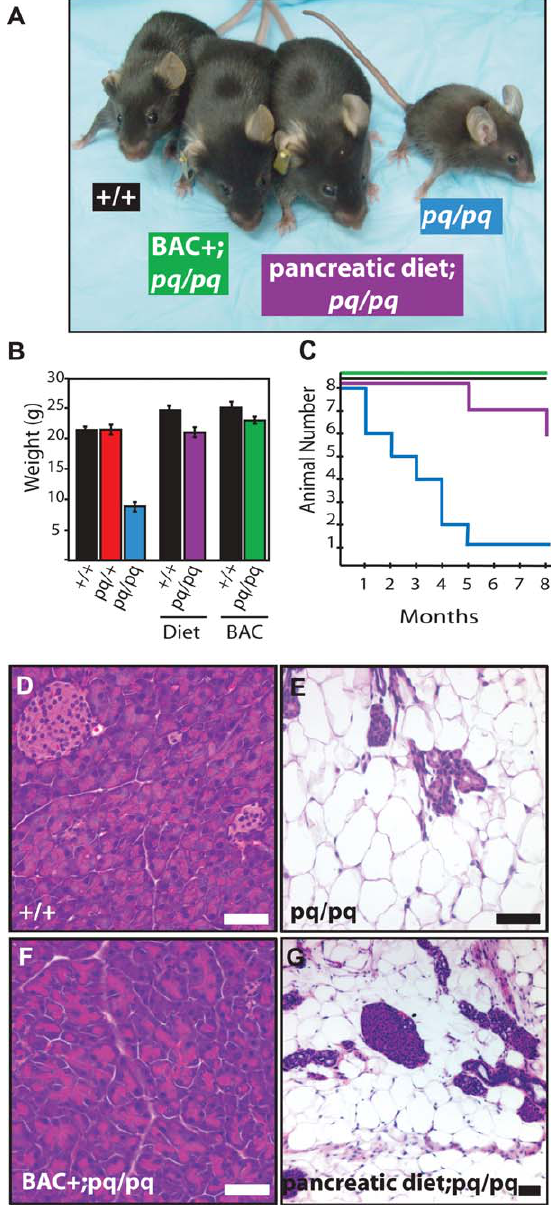
Figure 3. pequen˜o Malnutrition Is Rescued by BAC Transgenic Expressing Serpini2 Gene or Pancreatic Enzyme Diet Supplementation (A–C) Treatment of pq/pq mice (blue) pharmacologically with daily pancreatic enzyme diet supplement (purple) or genetically with BAC 150E1 transgene (green), rescues (A) size, (B) weight, and (C) animal viability in comparison to wild-type mice (black). For (B) weight measurements are averaged from n ¼ 6 males from each genotype. (D–G) Hematoxylin and eosin staining of pancreas sections from 8-wk- old mice. Wild-type mice (D) have normal pancreatic acinar cells present and normal pancreatic morphology while in (E) pq/pq mice there is a loss of acinar cells. In the BAC þ ; pq/pq mice (F), pancreas acinar cells are present. The acinar cell loss in pq/pq mice treated with enzyme supplementation (G) is the same as untreated pq/pq mice (A–C), although diet supplementation is effective in combating the effects of malnutrition. Bar represents 25 l m. DOI: